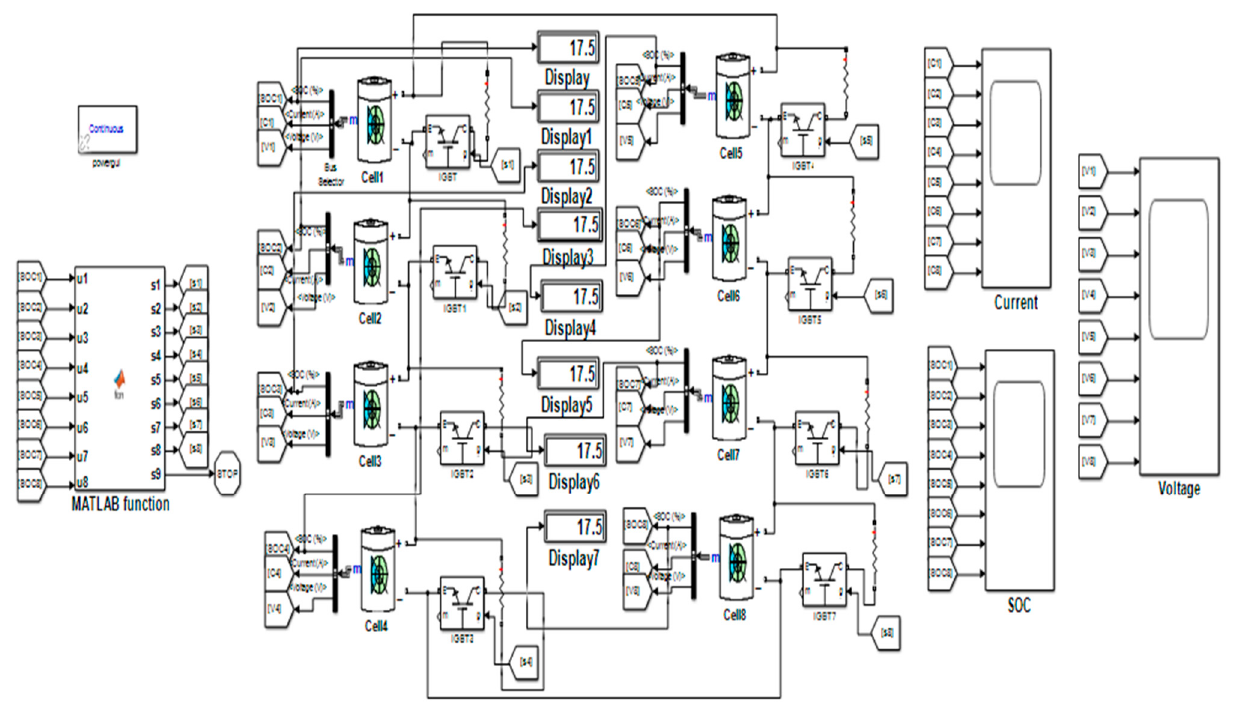
Figure 12. Passive cell balancing using Simulink.